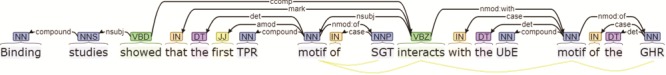
Grammatical dependencies graph.